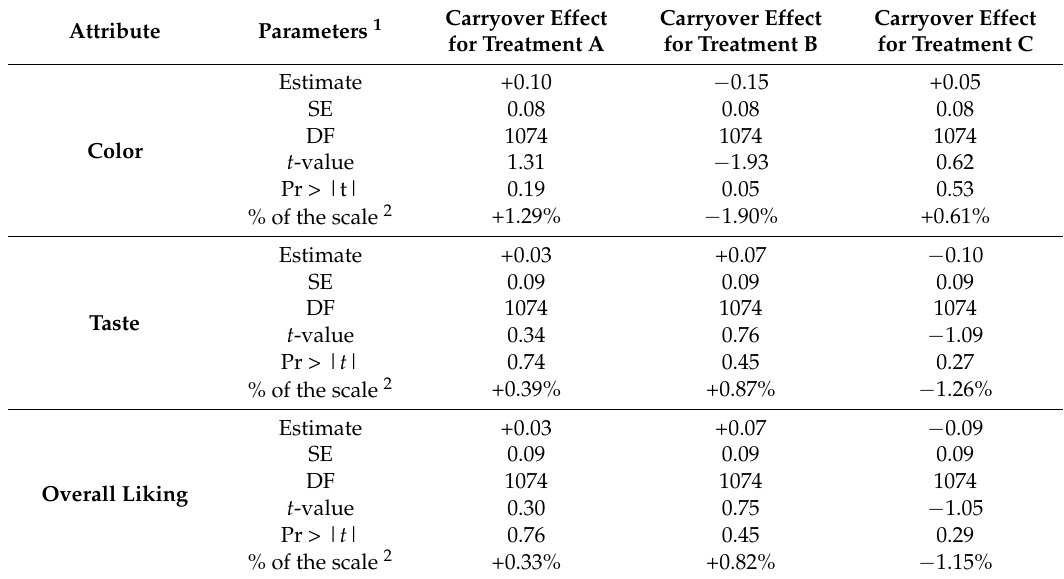
Table 5. Estimates of the carryover effects for different treatments on three attributes (color, taste, and overall liking) using model